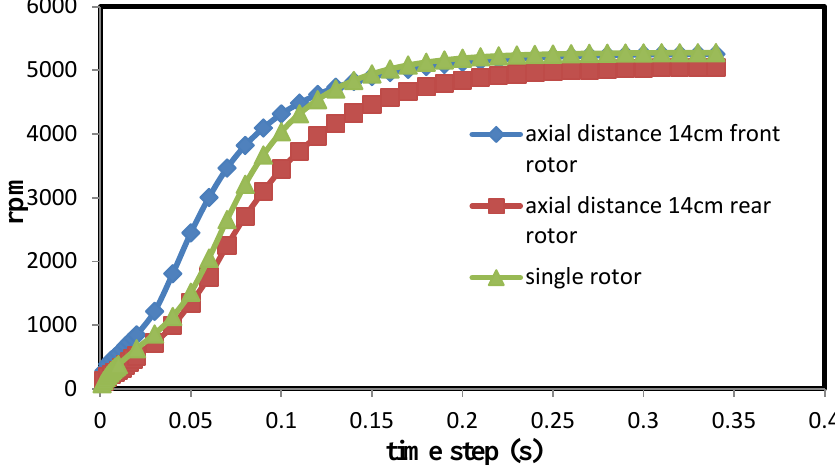
Figure 12. Comparison between SRRAT and CRRAT at an axial distance of 14